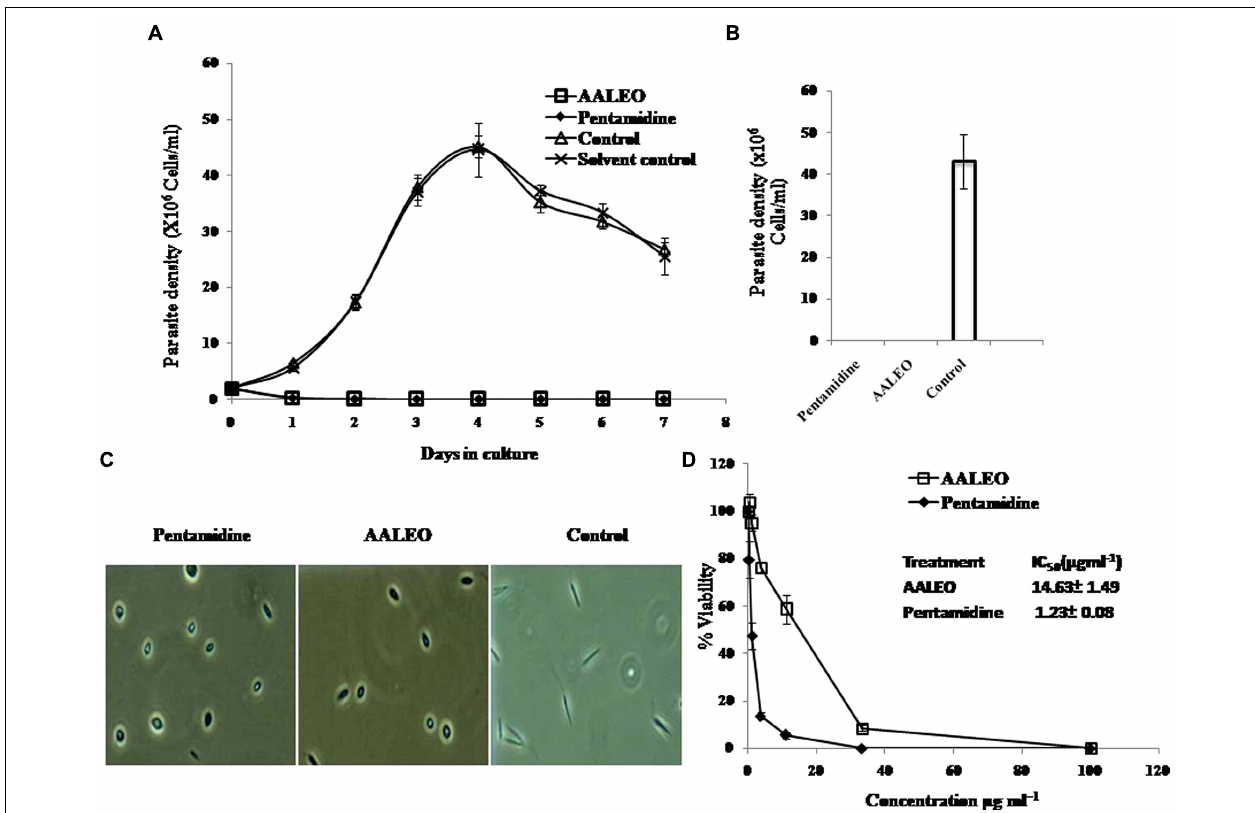
analysis of promastigotes by light microscopy (40 × ) at 72 h post-treatment and (D) % viability ascertained upon incubation